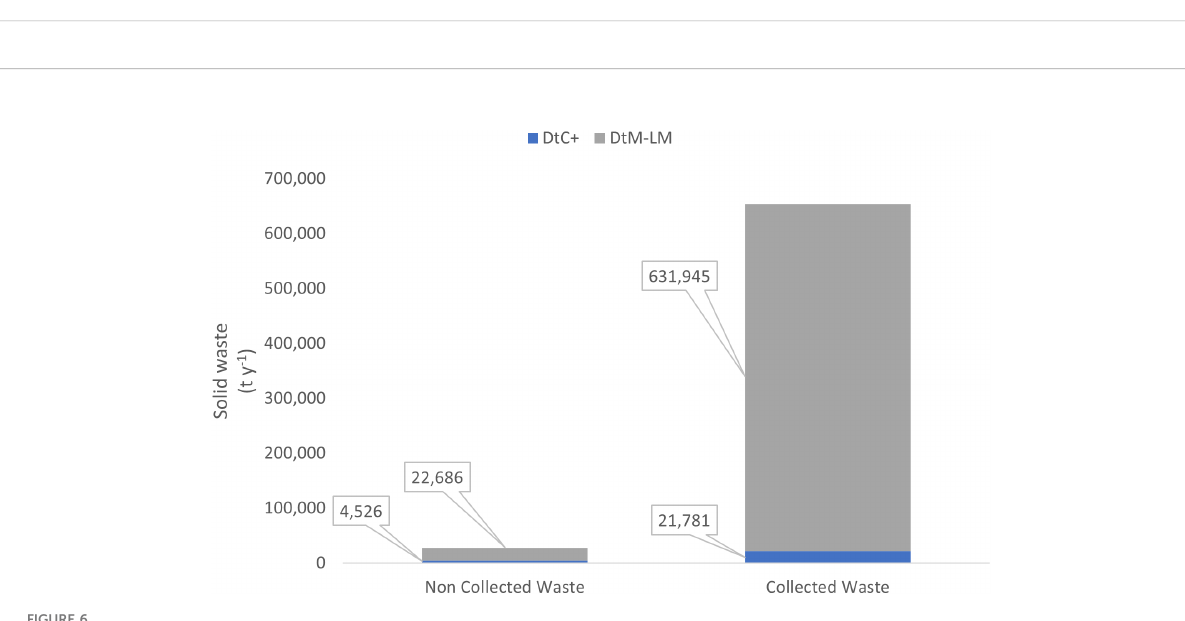
FIGURE 6 Collected and non-collected solid waste by basin.